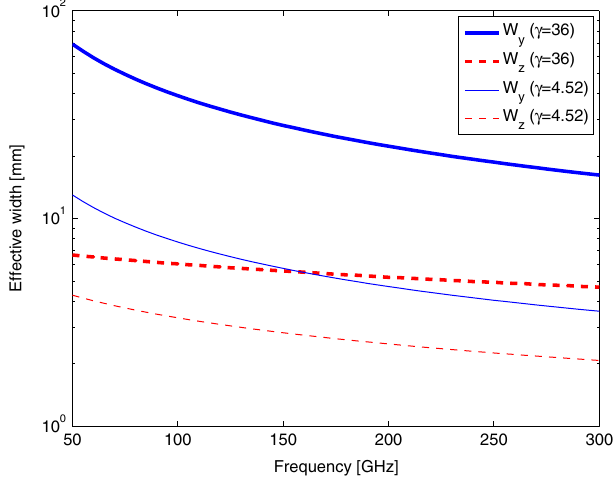
FIG. 2. (Color) Effective width of the parallel (solid lines) and transverse (dashed lines) components vs frequency for a charge traveling 0.6 mm above a grating. The effective width is calcu- lated for (cid:1) ¼ 36 (thick lines) and (cid:1) ¼ 4 : 52 (thin